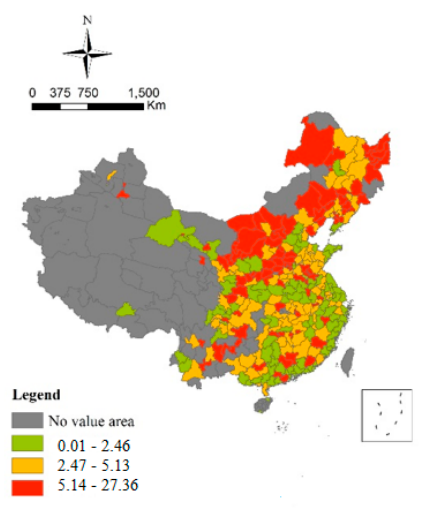
Figure 3. Carbon intensity distribution of Chinese cities. 349